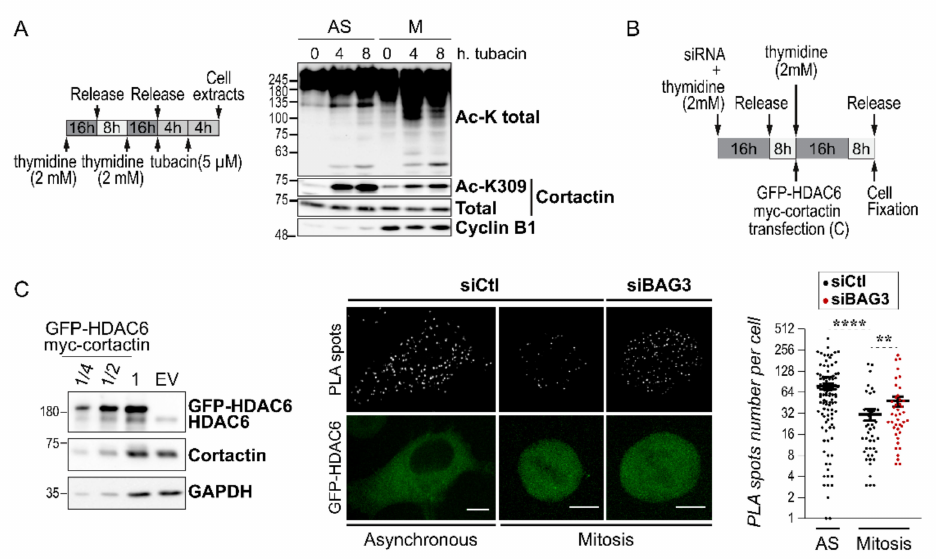
Figure 4. BAG3 depletion impairs the mitotic regulation of HDAC6–cortactin association. ( A ) Schematic of the protocol used to analyze protein acetylation. Representative Western blots showing the acetylation levels of total proteins (Ac-K) or cortactin acetylation (Ac-K309) in asynchronous (AS) versus mitotic HeLa cells (M); cyclin B1 levels were monitored as a marker of mitosis; total cortactin: loading control. ( B ) Schematic of the protocol used to assess HDAC6–cortactin association in situ. ( C ) Representative Western blots showing GFP-HDAC6 and myc-cortactin levels after transfection in HeLa cells; Glyceraldehyde 3-phosphate dehydrogenase (GAPDH): loading control, EV: empty vector. Representative confocal images show proximity ligation assay (PLA) signal using anti-GFP and anti-cortactin antibodies, and GFP-HDAC6 in an asynchronous cell versus a mitotic cell transfected with control siRNA (siCtl), as compared to a mitotic cell depleted of BAG3 (siBAG3). Scale bars: 10 µ m. The graph shows quantification of the number of PLA foci per cell; means +/ − SEM ( n ≥ 30 cells; N = 3 experiments). Statistical analysis was performed by the Mann–Whitney test; ****, p < 0.0001; **, p <